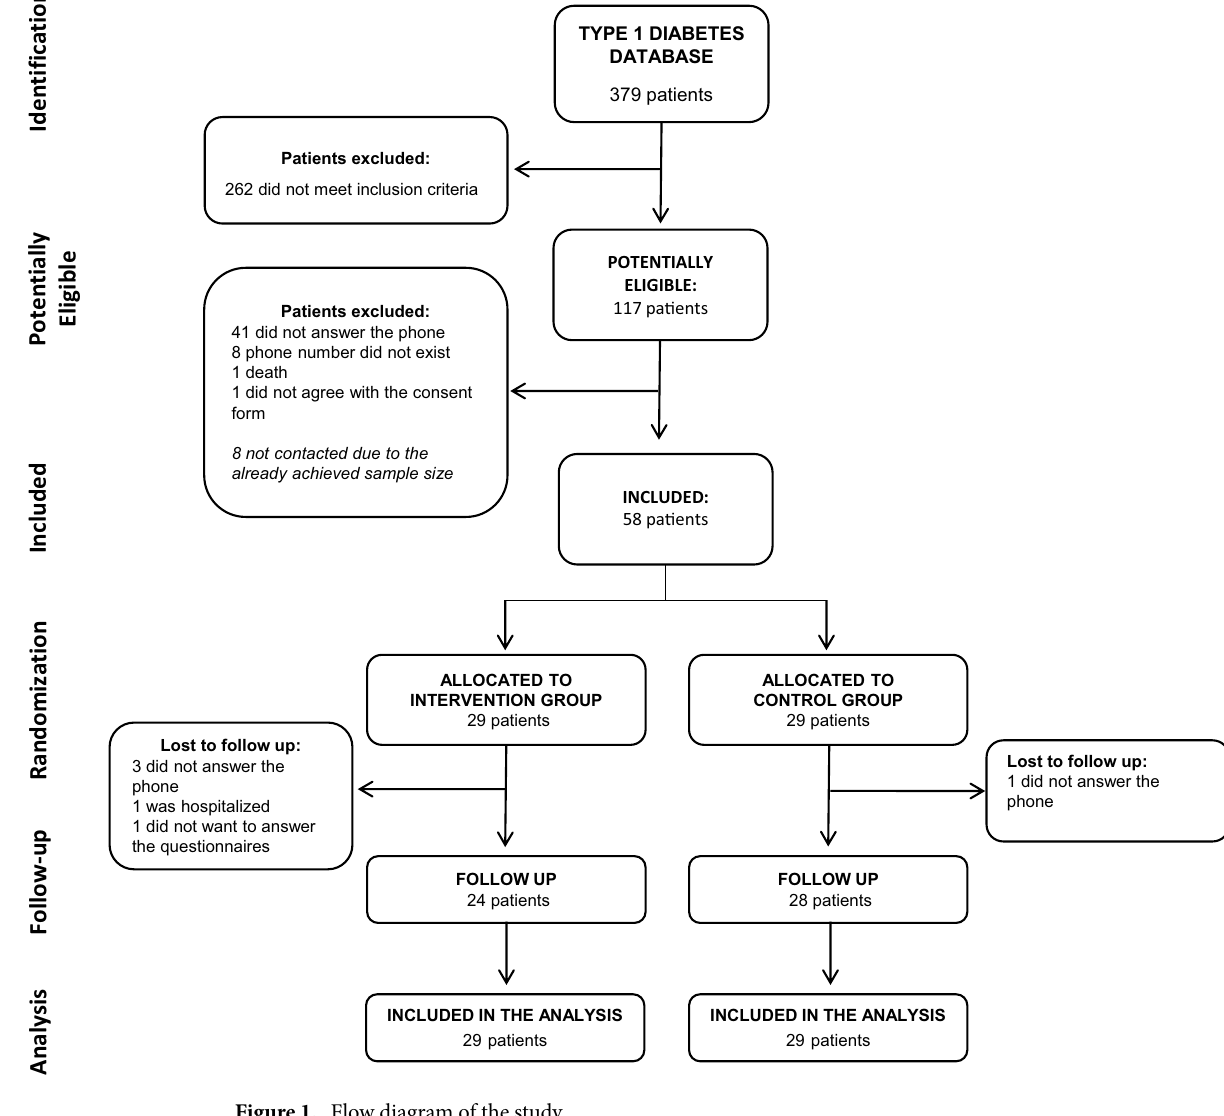
Figure 1. Flow diagram of the